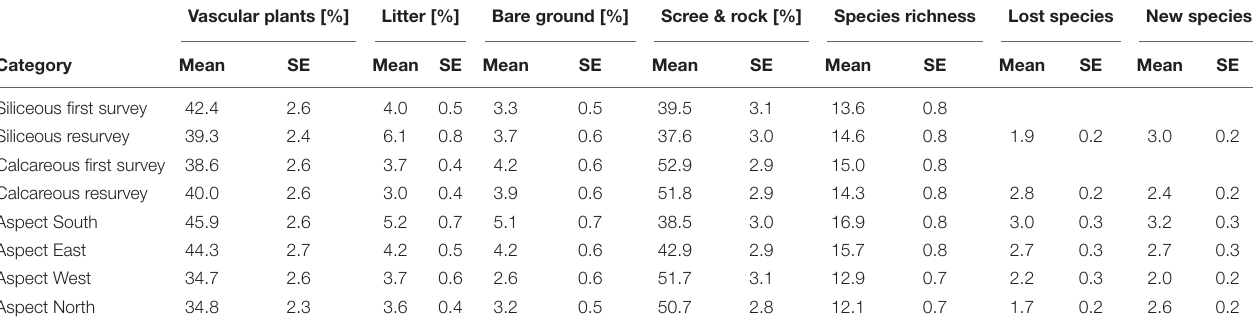
TABLE 3 | Table of means and standard errors (SE) for all analyzed response variables: surface cover types (“vascular plant cover,” “litter cover,” “bare ground cover”), “species richness,” number of “lost species”, and “new species” for the two bedrock types during the first survey/resurvey, and according to the